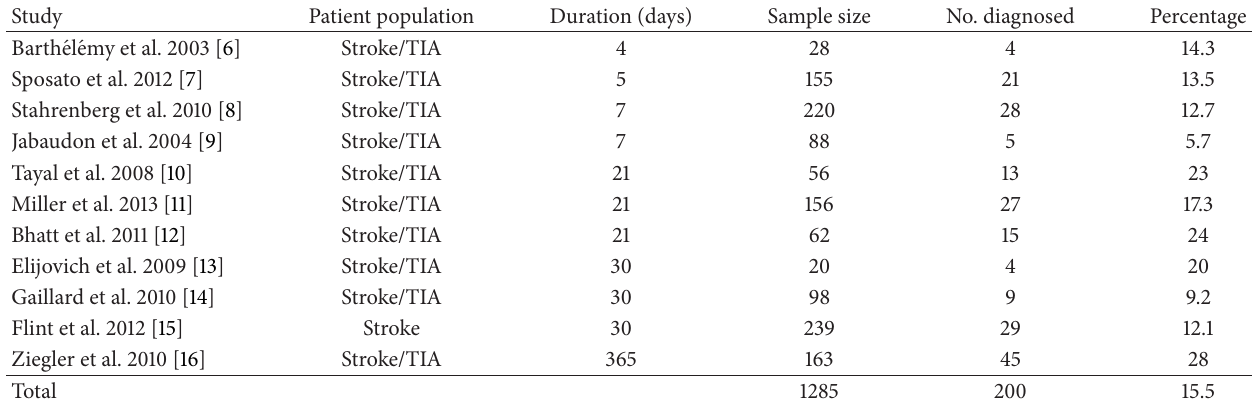
Table 1: Yield of long-term cardiac rhythm monitoring